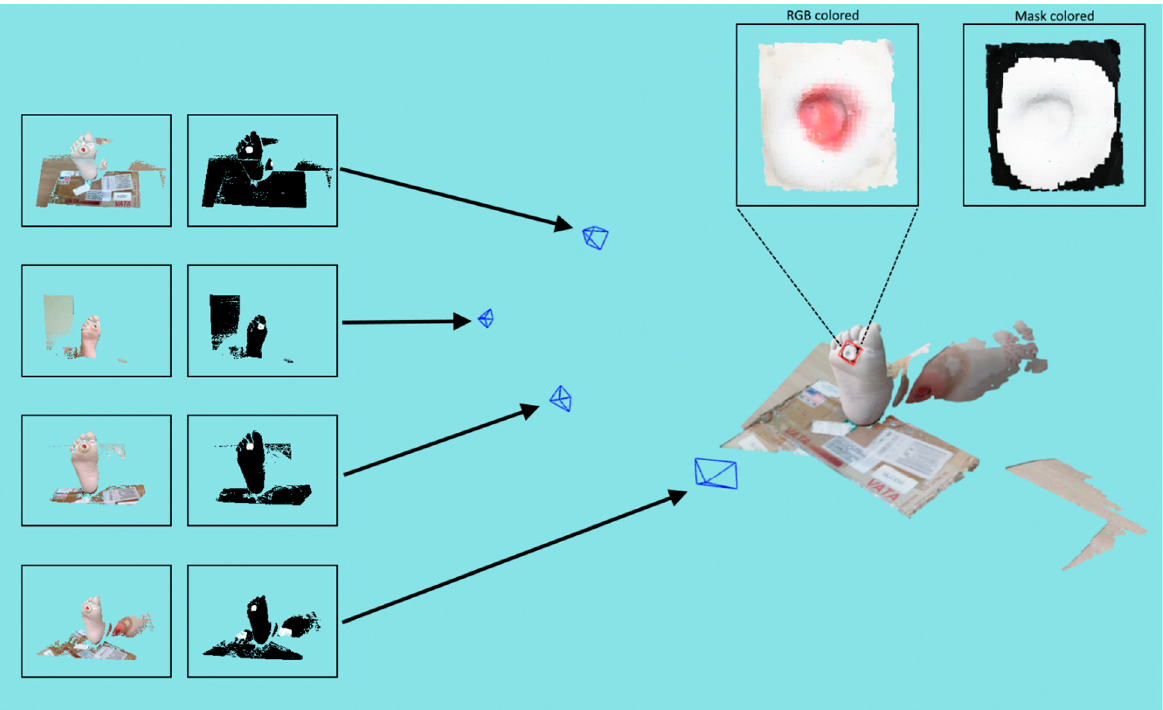
Figure 9. Example of optimized 3D point cloud mask labeling, where arrows point to the correspond- ing locations of the recordings on the left side of the figure. After the point cloud has been labeled by optimal reprojection, an initial mesh is cre- ated using the greedy point triangulation algorithm (GPT) [27] and the initial wound con- tour is designated by fi nding mesh vertices that have at least one neighbor labeled as non- wound. That contour is further subsampled by using only half of the points to create an initial contour for the active contour model used in the next phase. Figure 10 shows an example of the initial wound contour on a meshed local wound area.